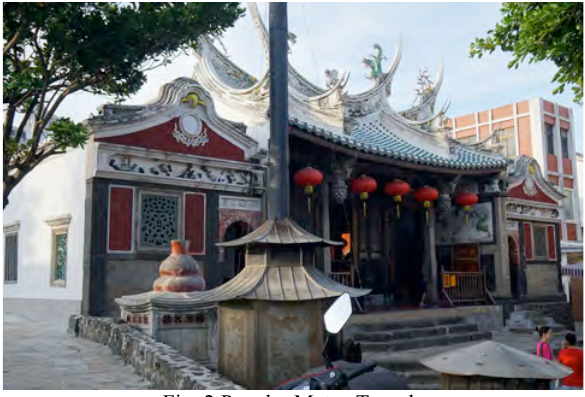
Fig. 2 Penghu Matsu